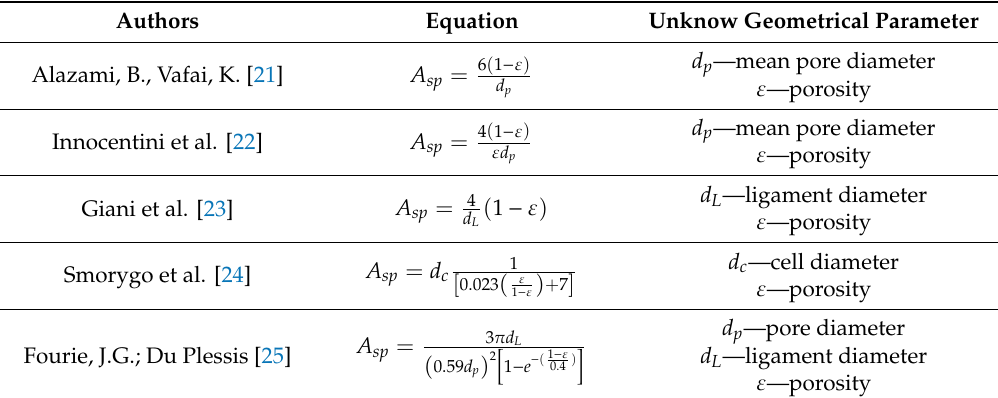
Table 1. The various methods of calculating the specific surface